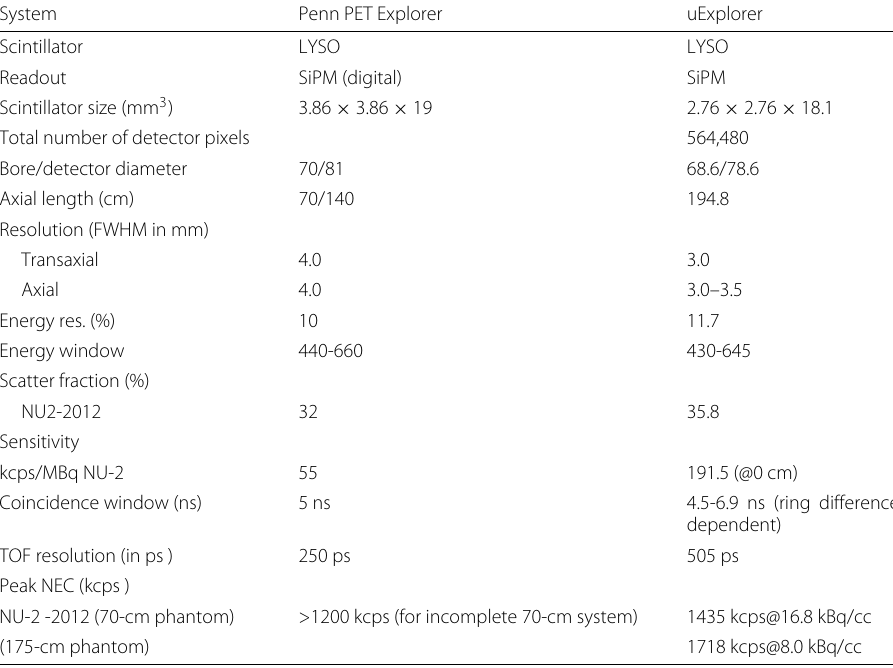
Table 2 Specifications of the developed human total body PET systems in the Explorer project System Penn PET